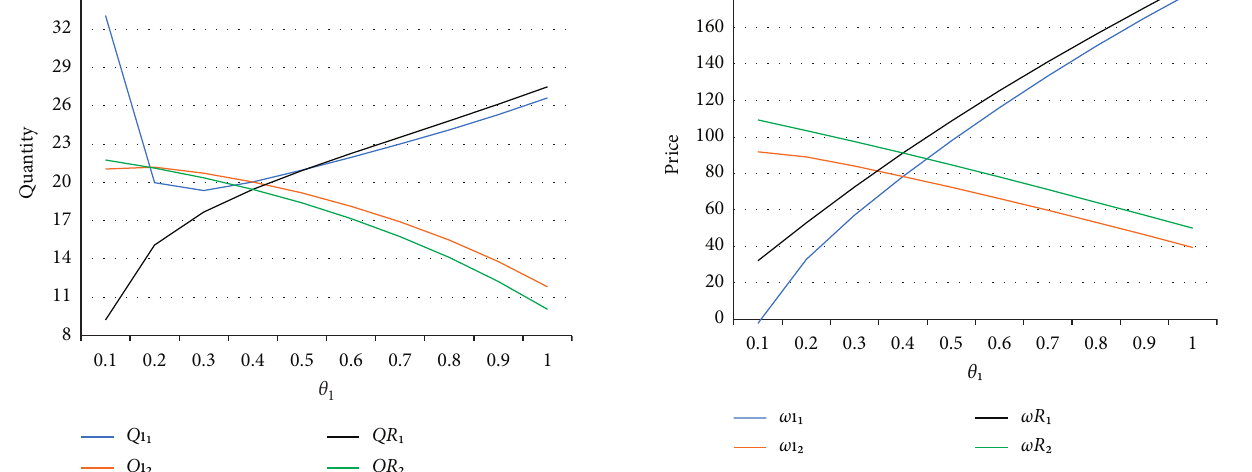
changes on supplier wholesale prices. 1